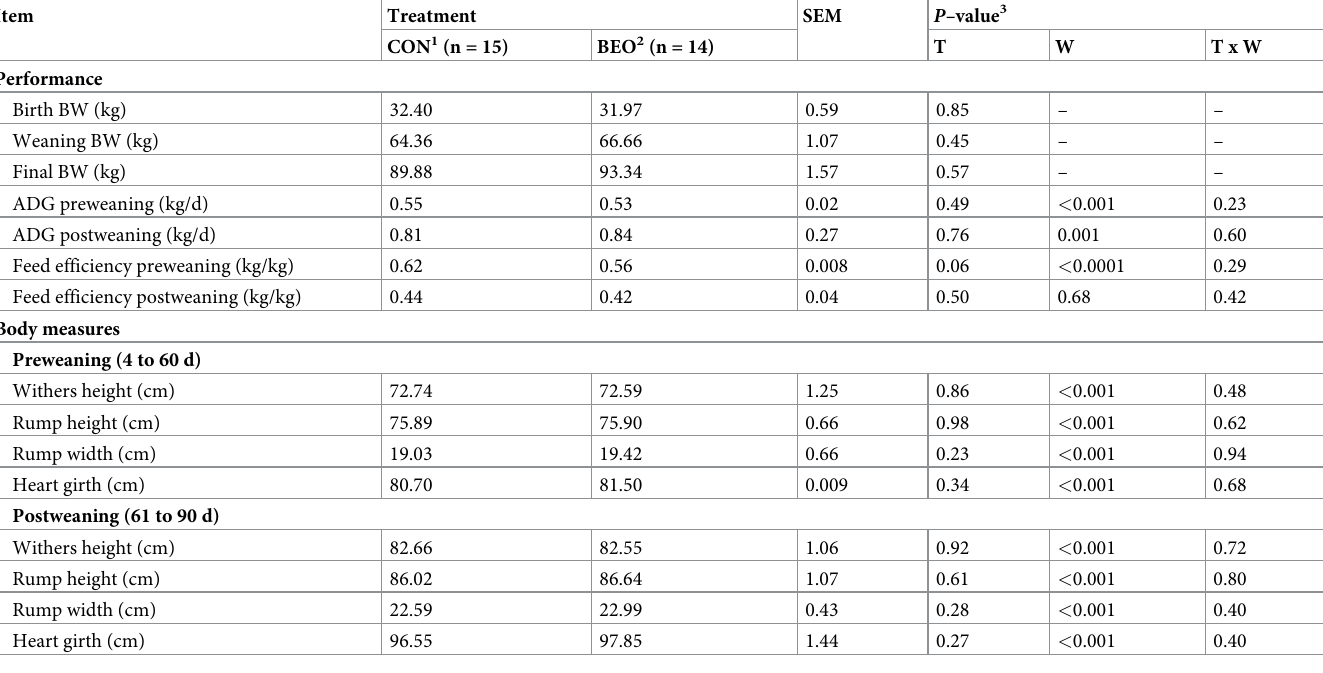
Table 3. Pre- and post-weaning performance and structural growth of heifers of control (CON) and supplemented with essential oils blend (BEO) in milk replacer during pre-weaning. Item